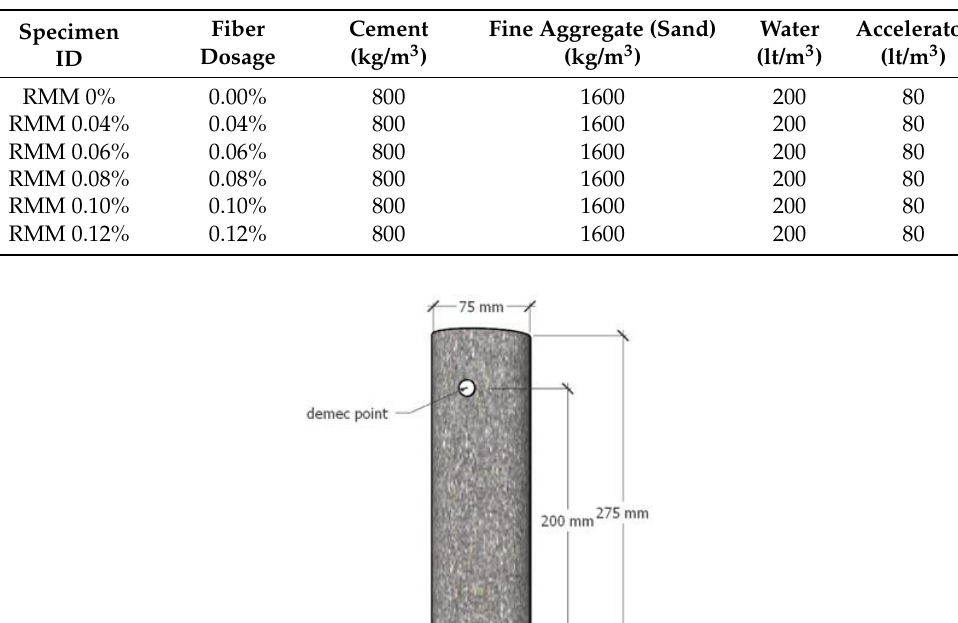
Table 2. Mix Proportion of micro-synthetic fibre-reinforced mortar.